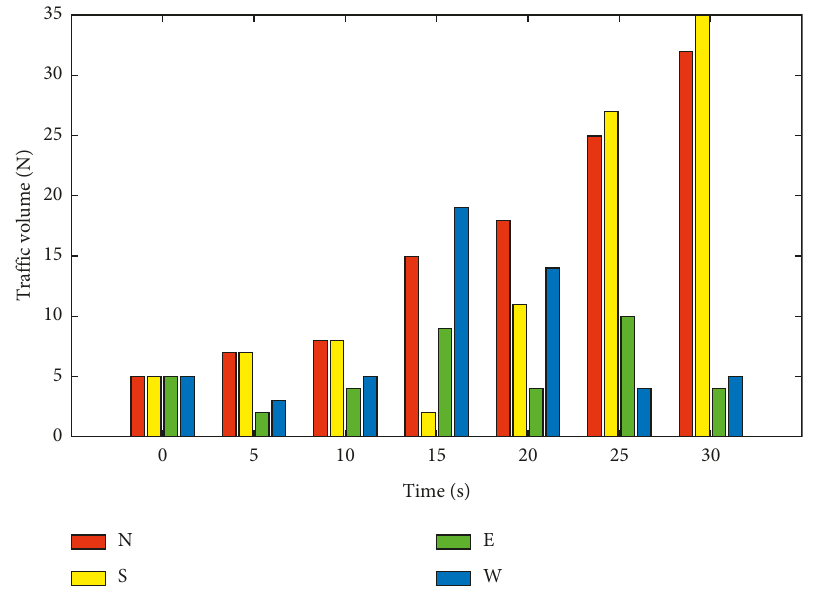
Figure 3: Simulation effect of the general traffic system.